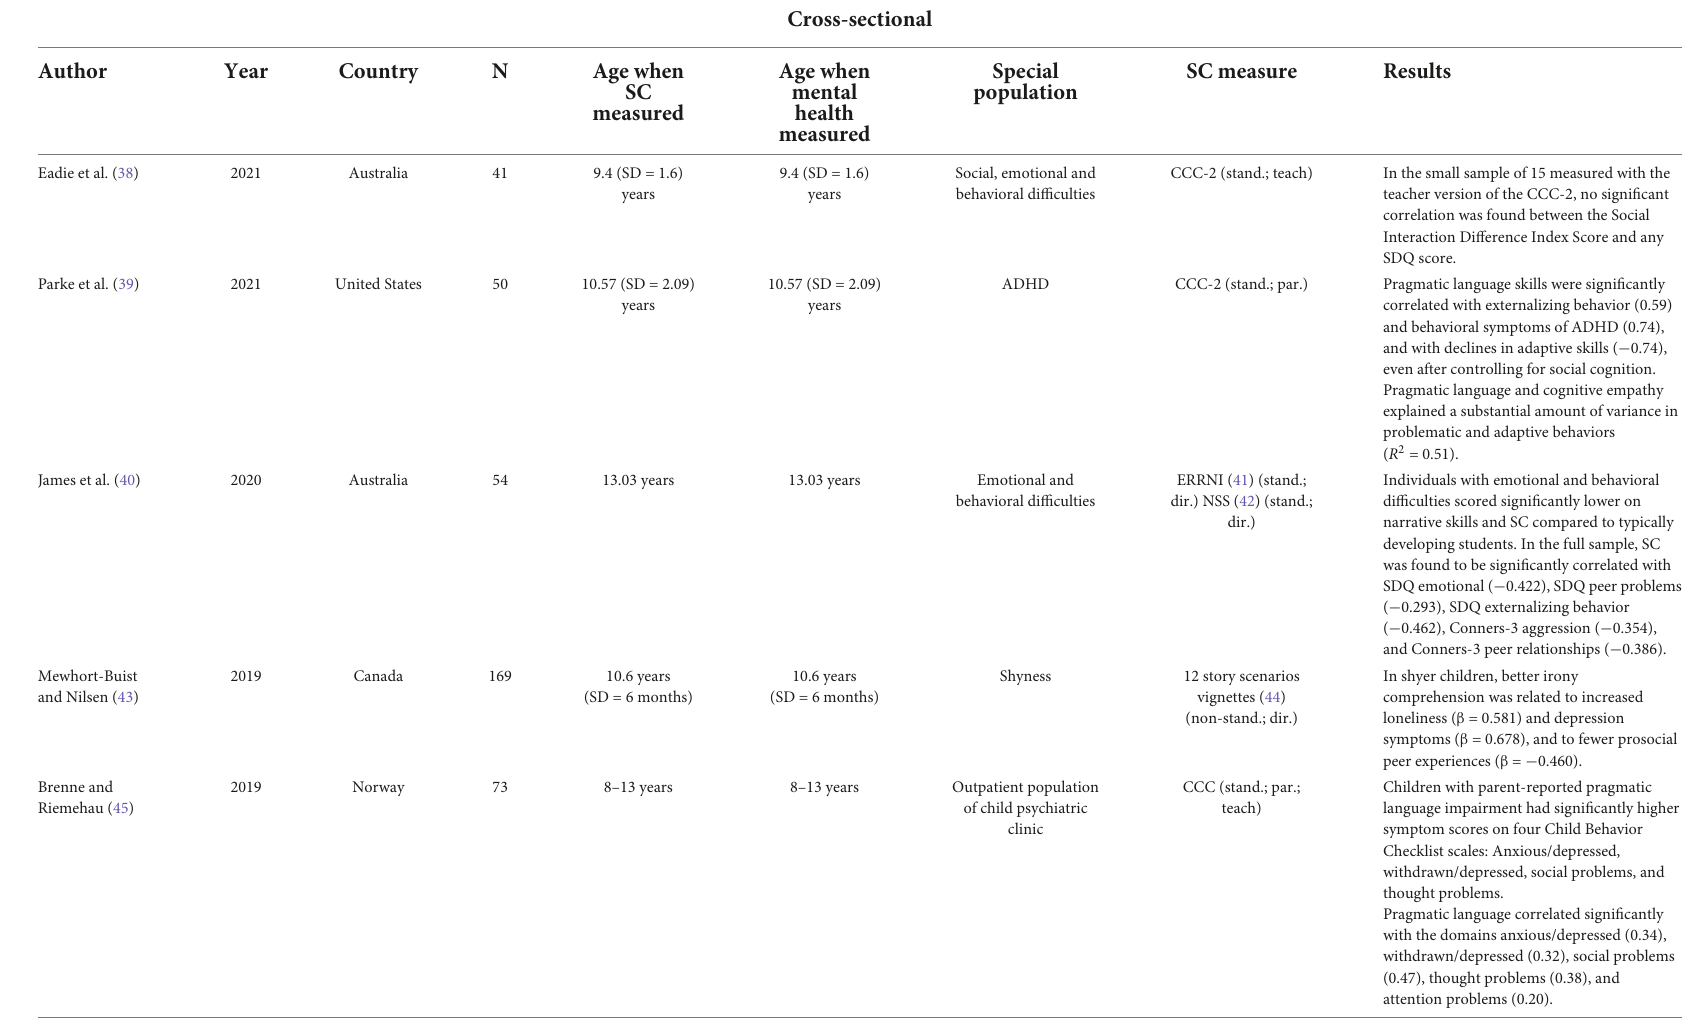
TABLE 3 Characteristics of special population cross-sectional